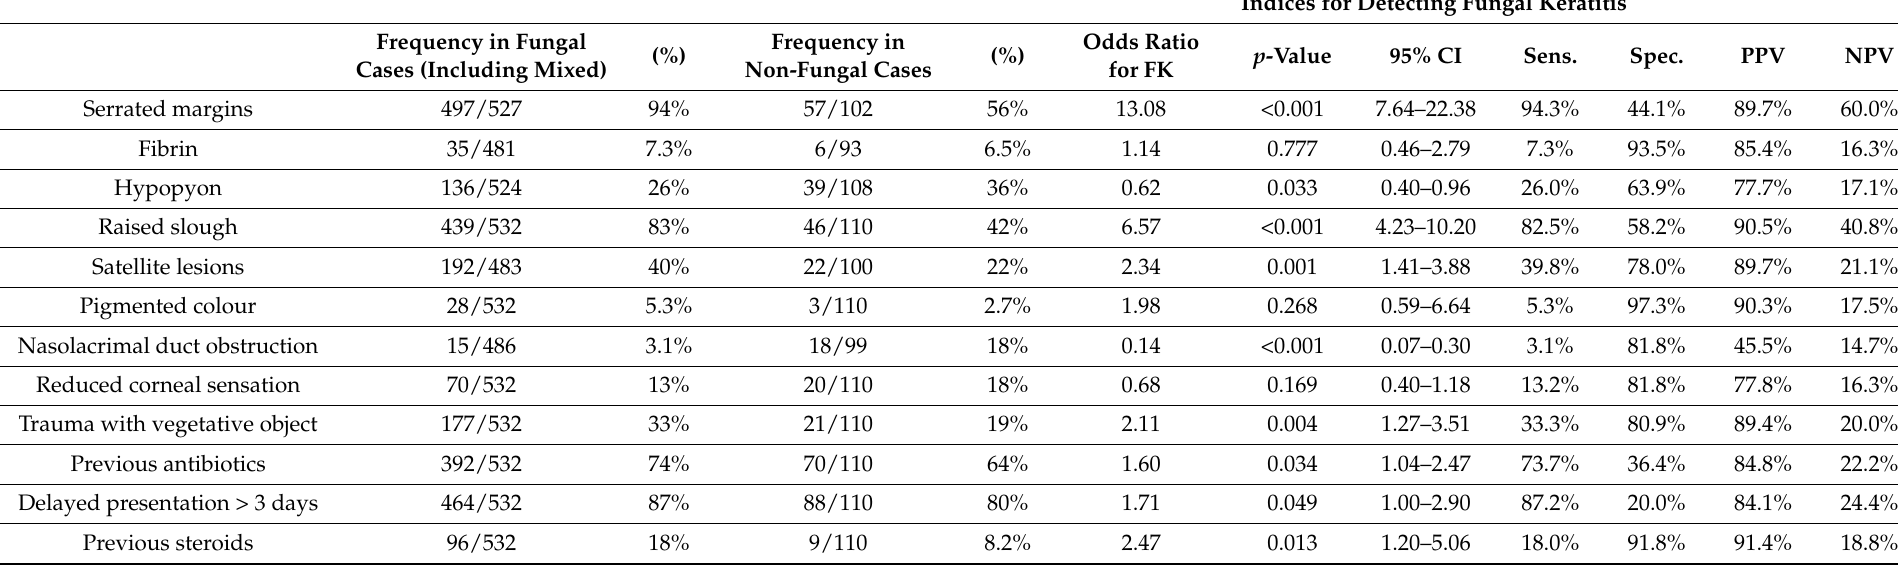
Table 5. Clinical features occurring in fungal and non-fungal keratitis (mixed infections included), with univariable analysis for features associated with fungal